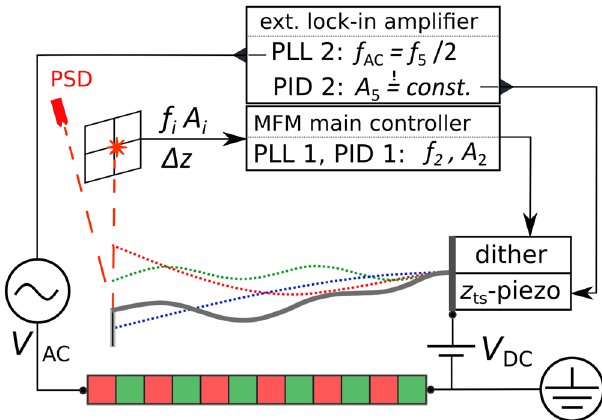
Fig. 7 Quantitative magnetic force microscopy setup. Schematic of the experimental setup and the multi-mode approach that allows for simultaneous magnetic fi eld and fi eld gradient microscopy supported by non-contact topography tracking. The magnetic force microscopy (MFM) setup (based on a Nanoscan AG hrMFM high-vacuum MFM) comprises